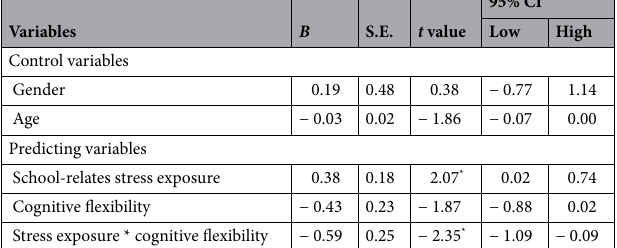
Table 3. The interactive effect of school-related stress exposure and cognitive flexibility on maladaptive coping (estimated coefficients, standard errors, and 95% confidence intervals). CI confidence interval. * p <